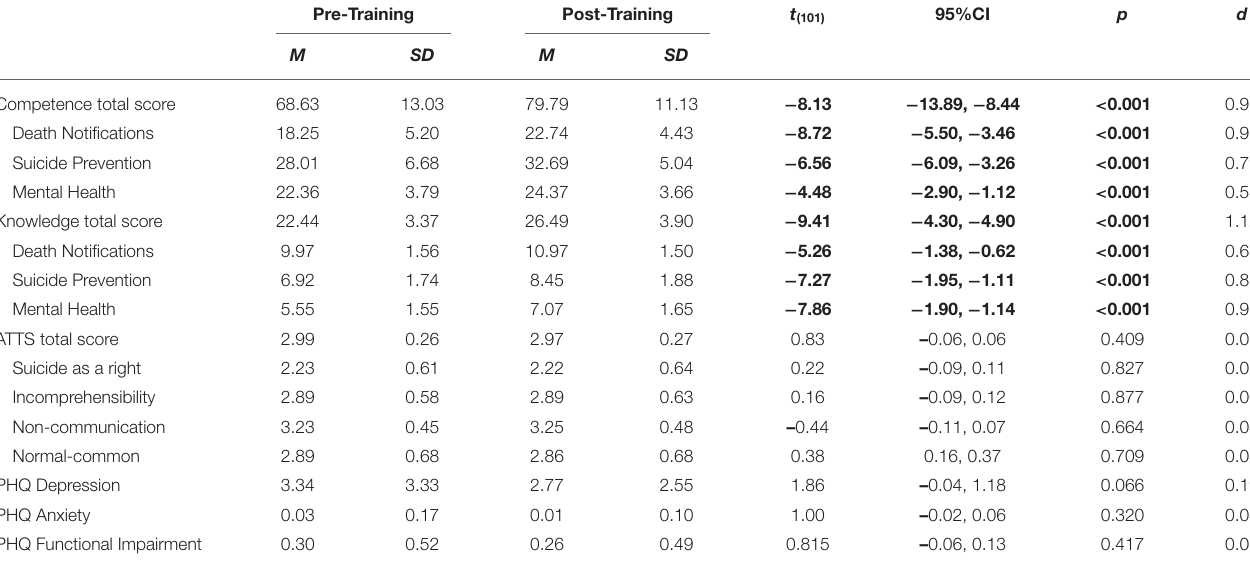
TABLE 2 | Descriptives and t -tests for baseline and post training ( N = 102). Pre-Training